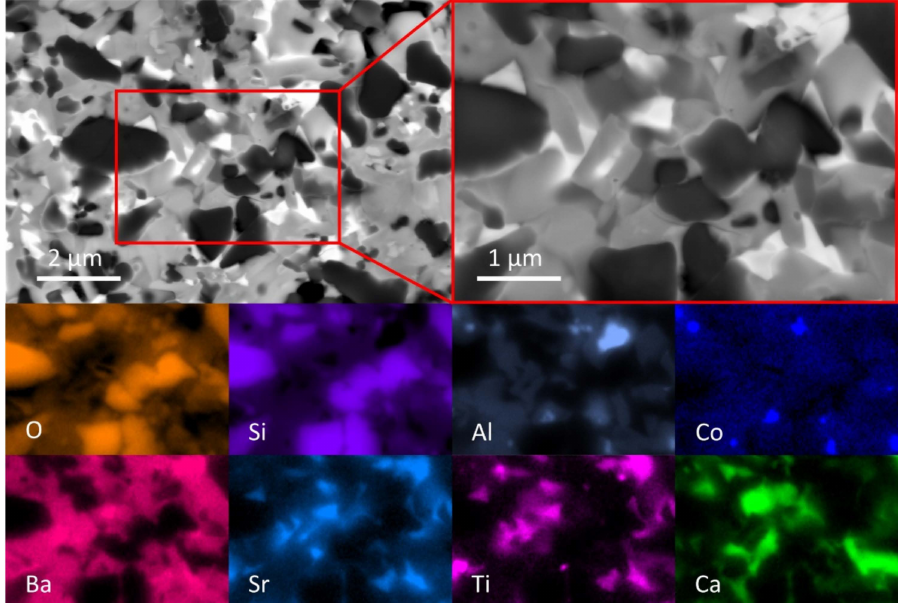
Figure 4. SEM micrographs (BSE mode, upper line) and individual EDX element maps (lower two lines) at the same position as the BSE micrograph (upper right) of CT708 sintered at 900 ◦